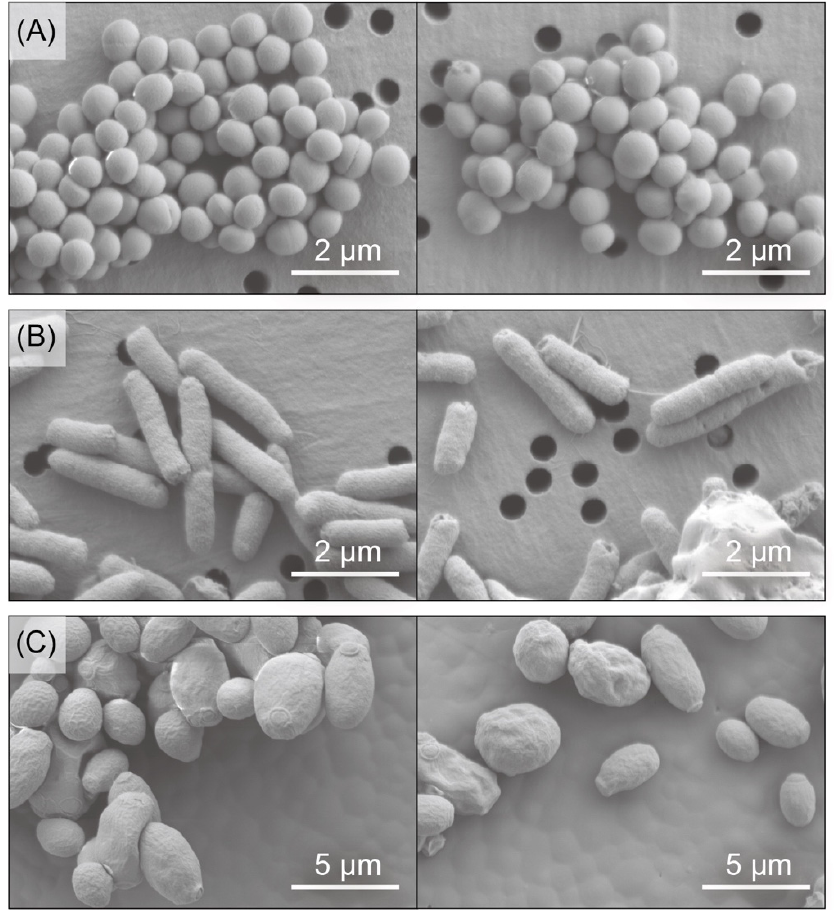
Figure 4. Scanning electron microscopic images of S. aureus ( A ), E. coli ( B ), and C. albicans ( C ) cells in the absence (left panel) and presence (right panel) of 110 µM CKR12-PLGA.